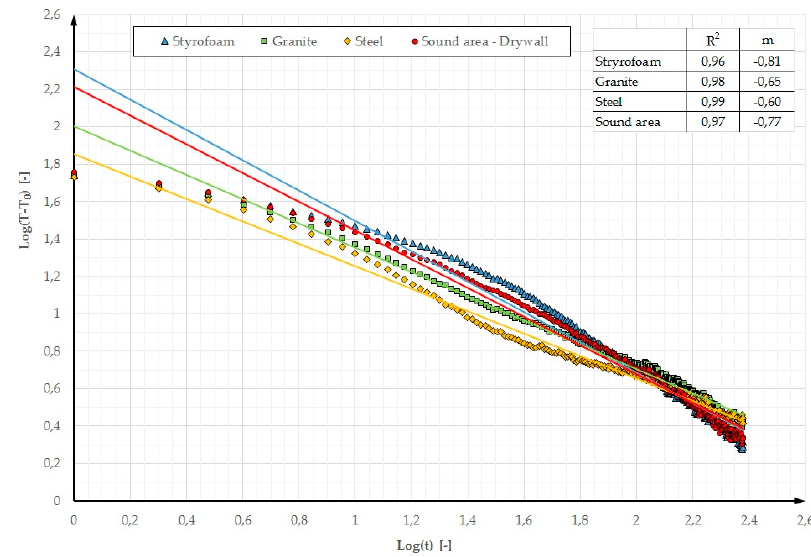
Figure 16. Log–log graph of the cooling phase and R 2 and m values (stimulated period of 30 min) for the OSB partition model with heating from a distance of 0.5 m.